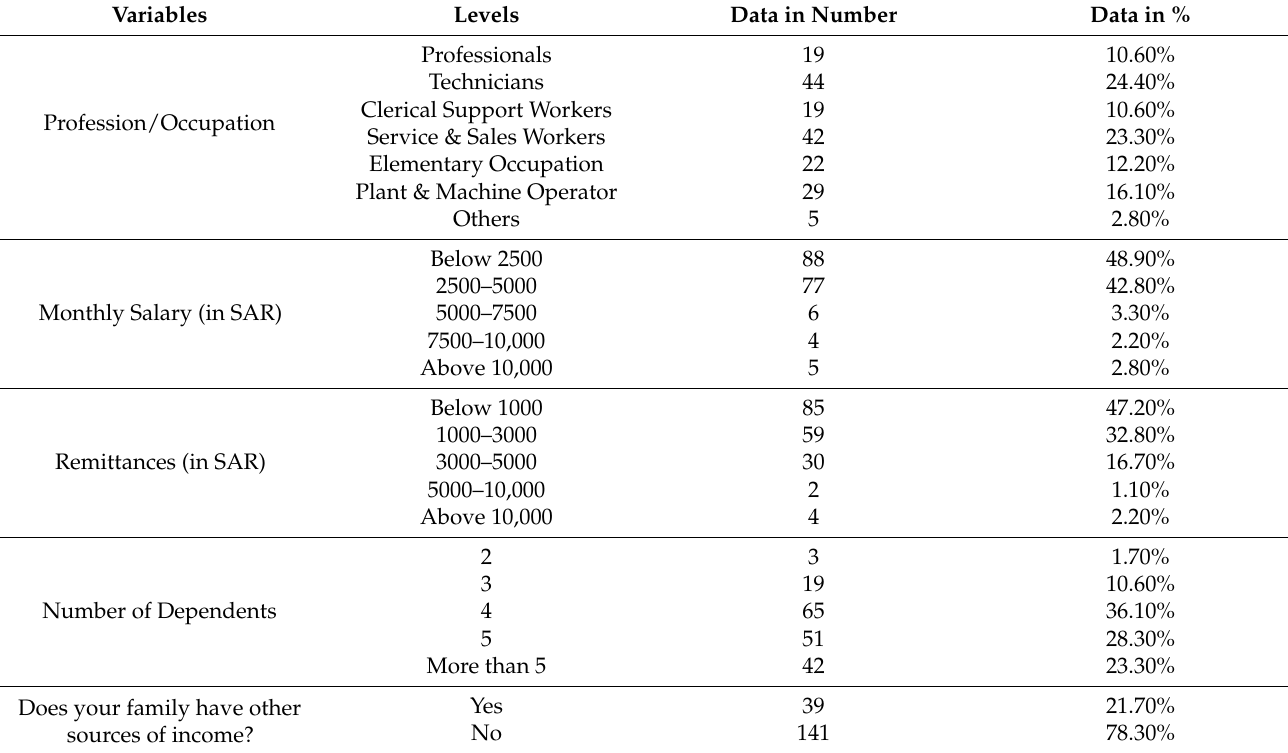
Table 2. Structure of Employment Status and